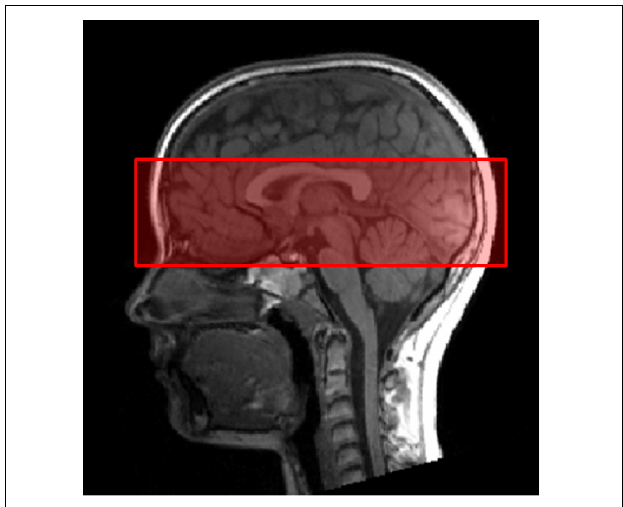
FIGURE 2 | Slab orientation covering bilateral OFA, FFA, and pSTS. The slab was oriented at the lowest part of the occipital pole and the lowest part of the prefrontal cortex (PFC), using the middle view of the structural